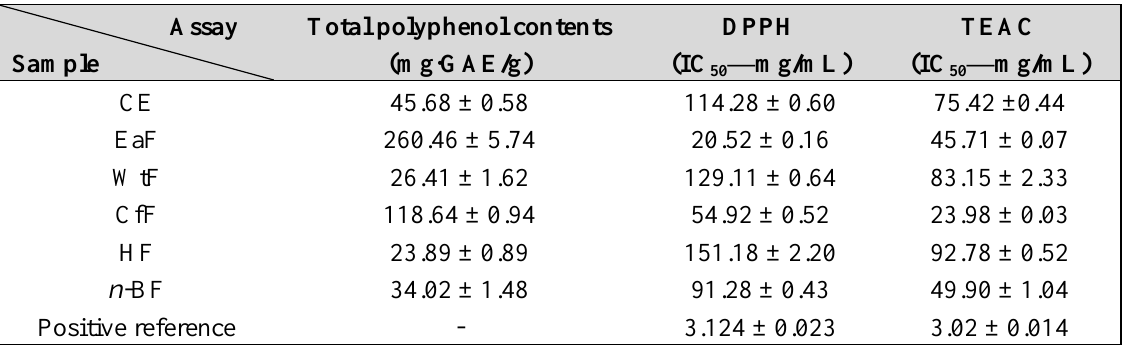
Table 2. Total polyphenol contents, DPPH radical scavenging activity and Trolox equivalent antioxidant capacity (TEAC) of Wissadula periplocifolia.